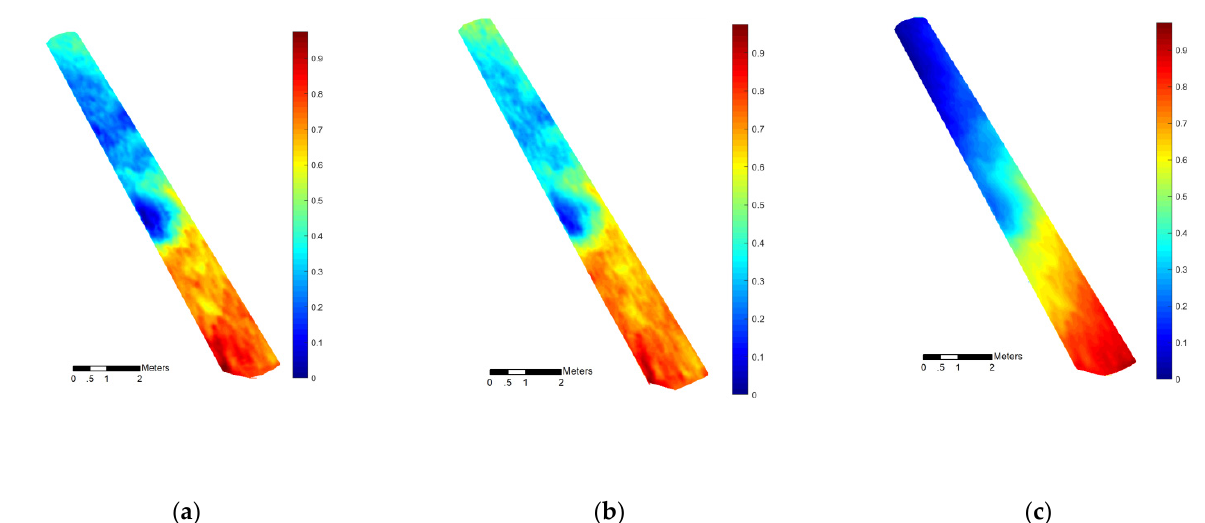
Figure 20. Reconstruction DEM results of ROI1 by three methods ( a ) SGM interpolation result, ( b ) PPS interpolation result, ( c ) PSOP result from orthorectified images.